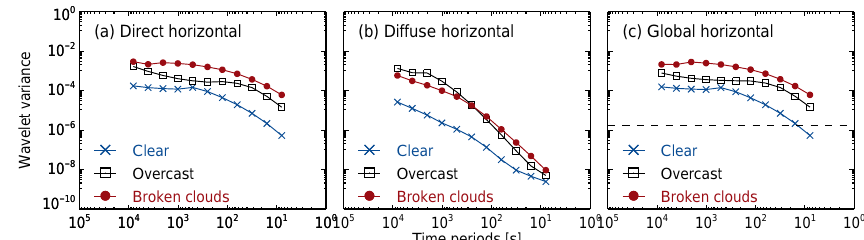
Figure 11. Power spectrum of the (a) direct, (b) diffuse, and (c) global transmittance as a function of temporal frequency for a clear-sky (4 July 2015), overcast (21 June 2015), and a broken cloudy-sky (17 June 2015) conditions observed during the HOPE Melpitz experiment. The black dashed horizontal line in (c) represents the combined measurement uncertainty of the pyranometer system.